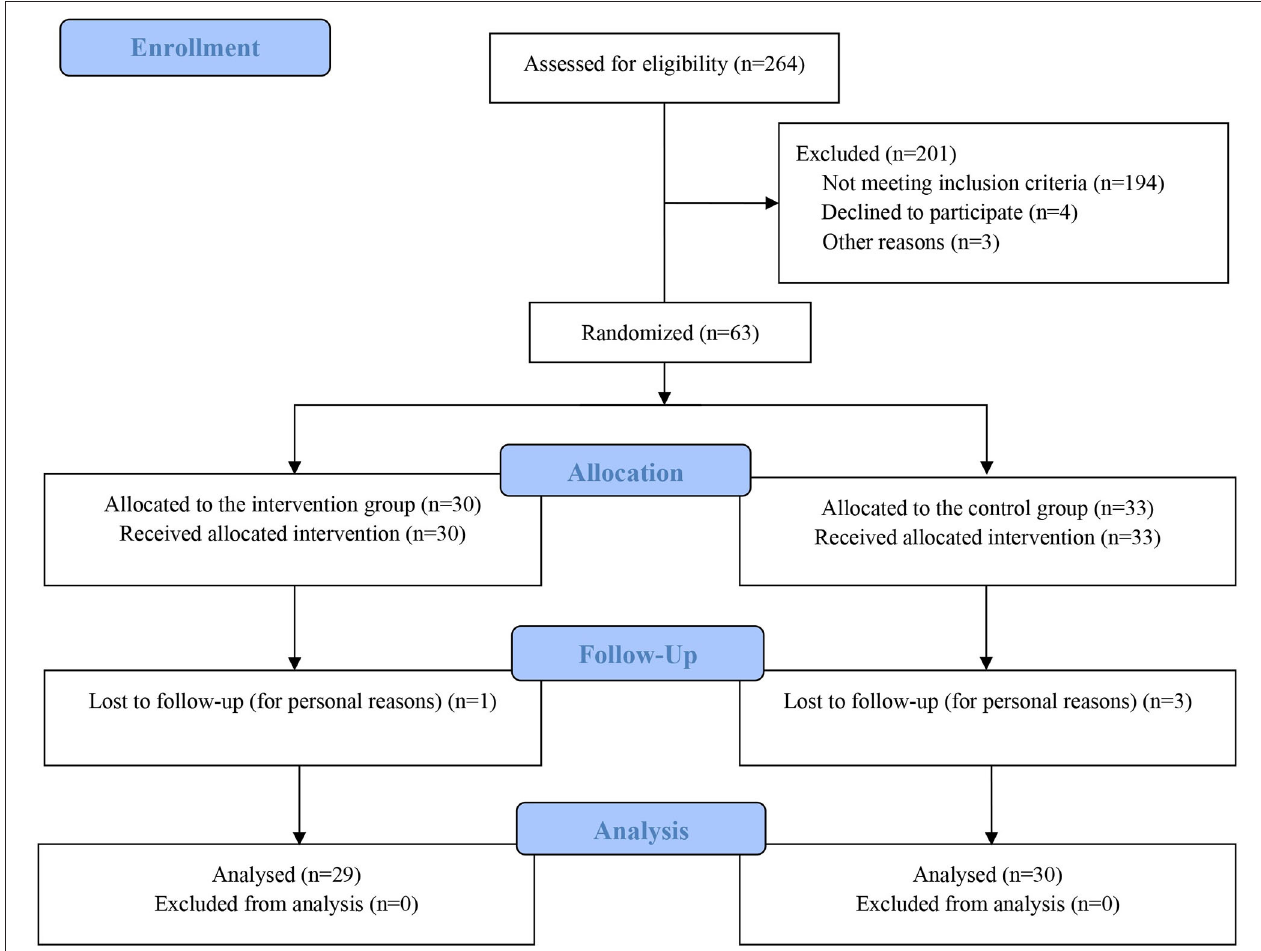
FIGURE 1 | Study how chart showing the process of patient selection and enrollment, allocation to the two study groups, and rate of patients completing the study. HPLG group, high-protein and low glycemic index dietary regimen; Control group, conventional balanced dietary regimen.